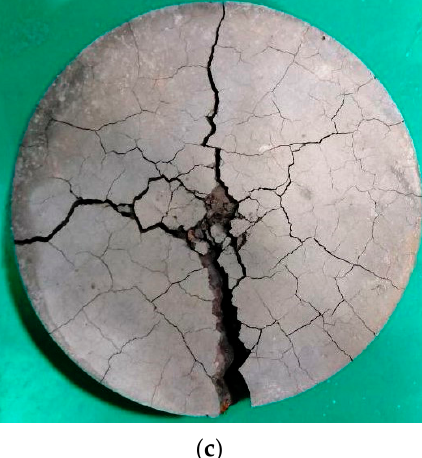
Figure 17. Failure patterns of cylindrical specimens heated to 600 °C: ( a ) M20, ( b ) M40, ( c ) M80.